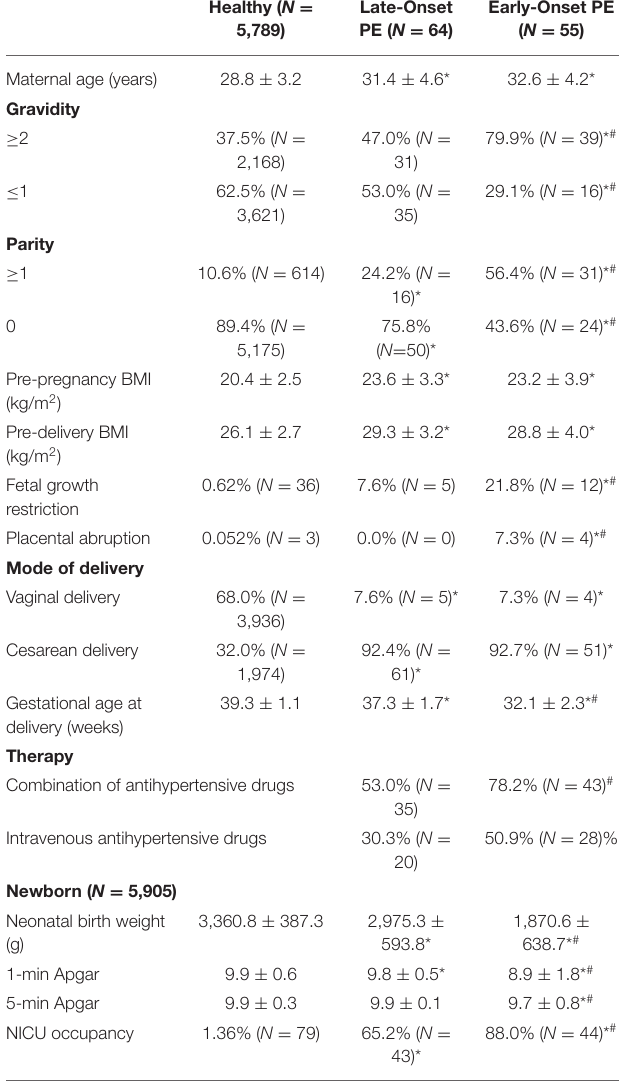
TABLE 1 | Demographic and clinical characteristics of the three study groups. TABLE 2 | Maternal lipid profiles in healthy pregnancy, late-onset PE, and early-onset PE.